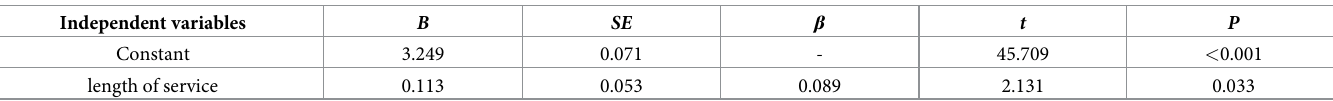
Table 7. Regression analysis of the DCS of